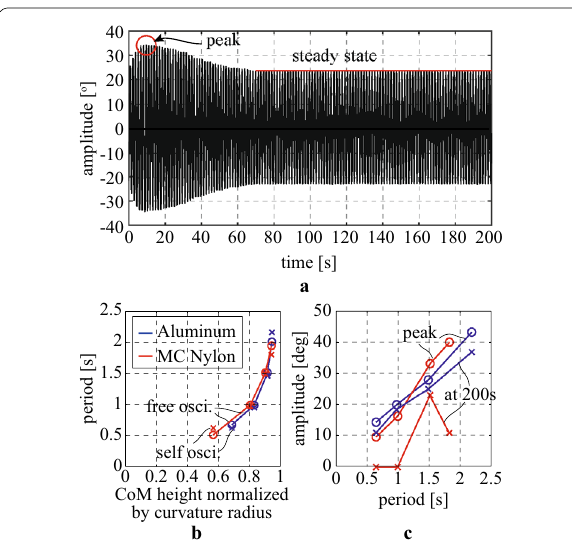
Fig. 9 Results of the amplitude measurement for the oscillators. a Time‑course variation, b oscillation period for different CoM heights, and c peak and steady‑state amplitudes for different conditions. Although the peak amplitude is the same regardless of the materials, only the oscillator made out of aluminum could keep large amplitude